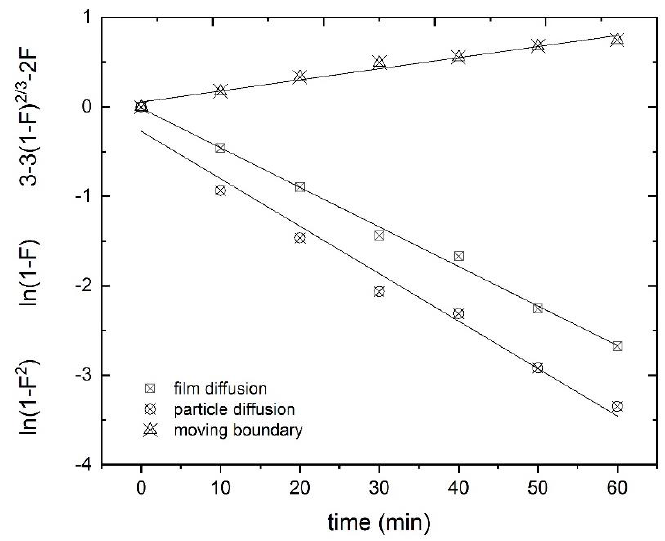
Figure 14. Rate laws fitted for the different adsorption mechanisms.